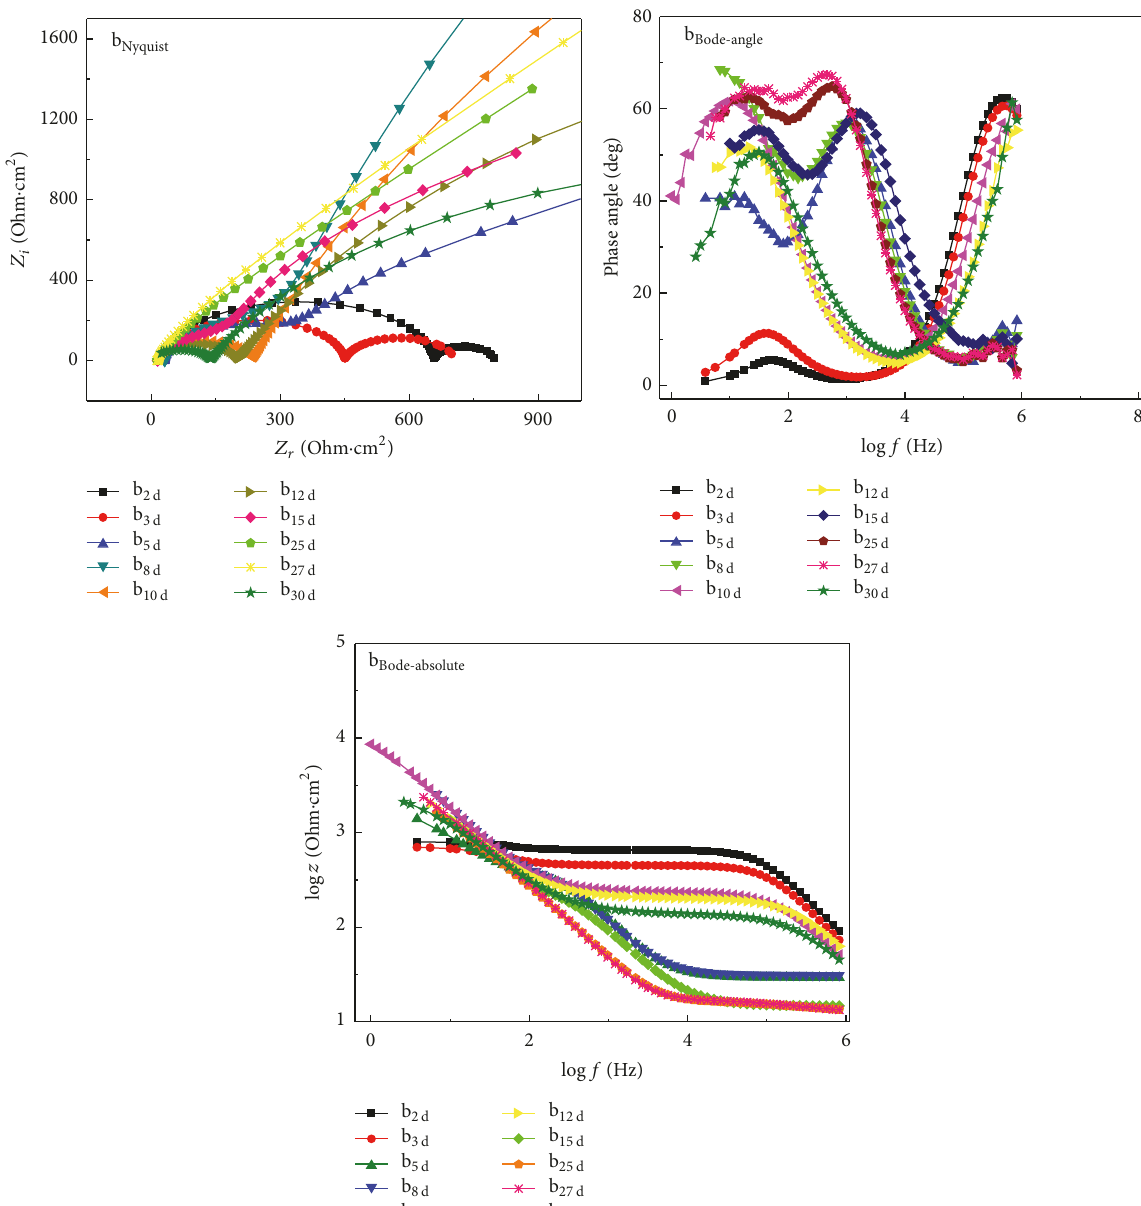
Figure 5: 2024-T31 aluminum-magnesium alloy immersed in b experimental system 2–30 d of the Nyquist plot and Bode plot.